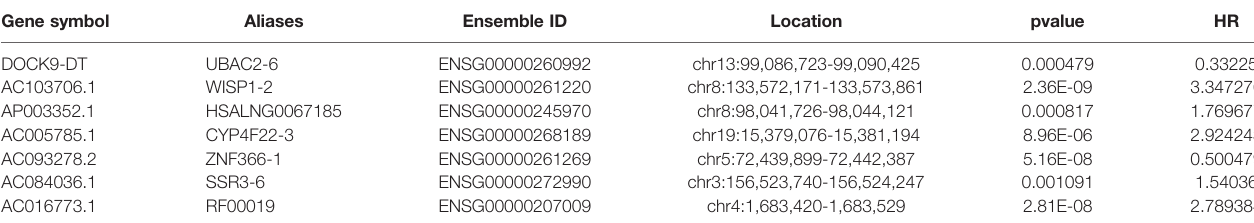
TABLE 1 | 7 metastasis-related lncRNAs signi fi cantly associated with the OS of ccRCC patients. Gene symbol Aliases Ensemble ID Location pvalue HR